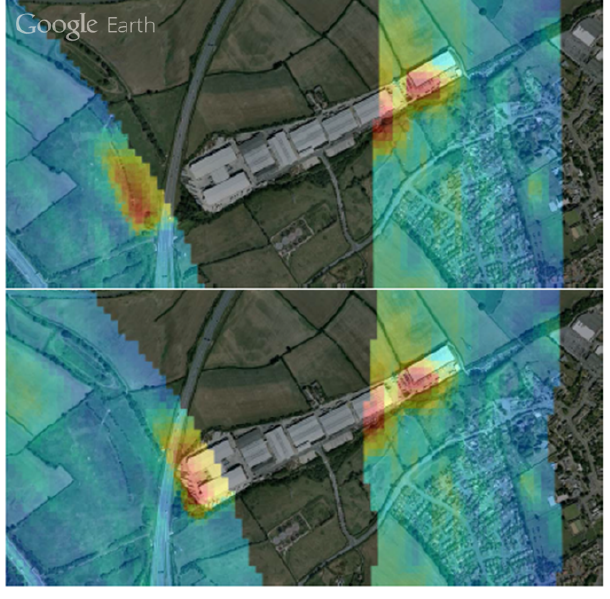
Figure 6. Top: CompAQS 442.7nm intensity data showing incor- rect georeferencing prior to banking correction. Bottom: CompAQS 442.7nm intensity data showing improved georeferencing follow- ing banking correction. Two swaths are shown, one during banking (left) and one during level flight (right). Both swaths are overlaid on Google Earth.